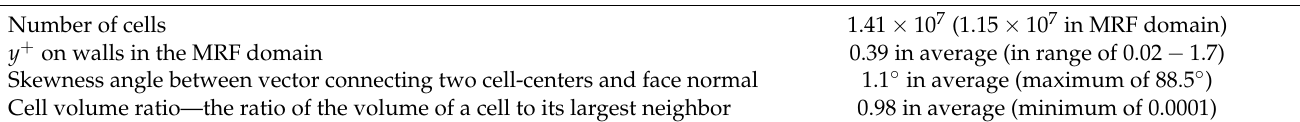
Table 3. The fine mesh used in a base simulation and the grid convergence index (GCI) based on the thrust and